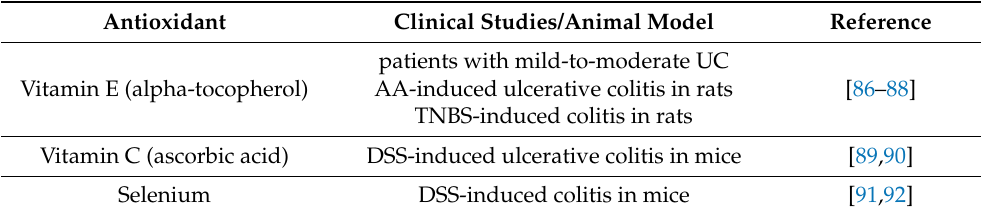
Table 3. Micronutrient antioxidants used in IBD therapy. Antioxidant Clinical Studies/Animal